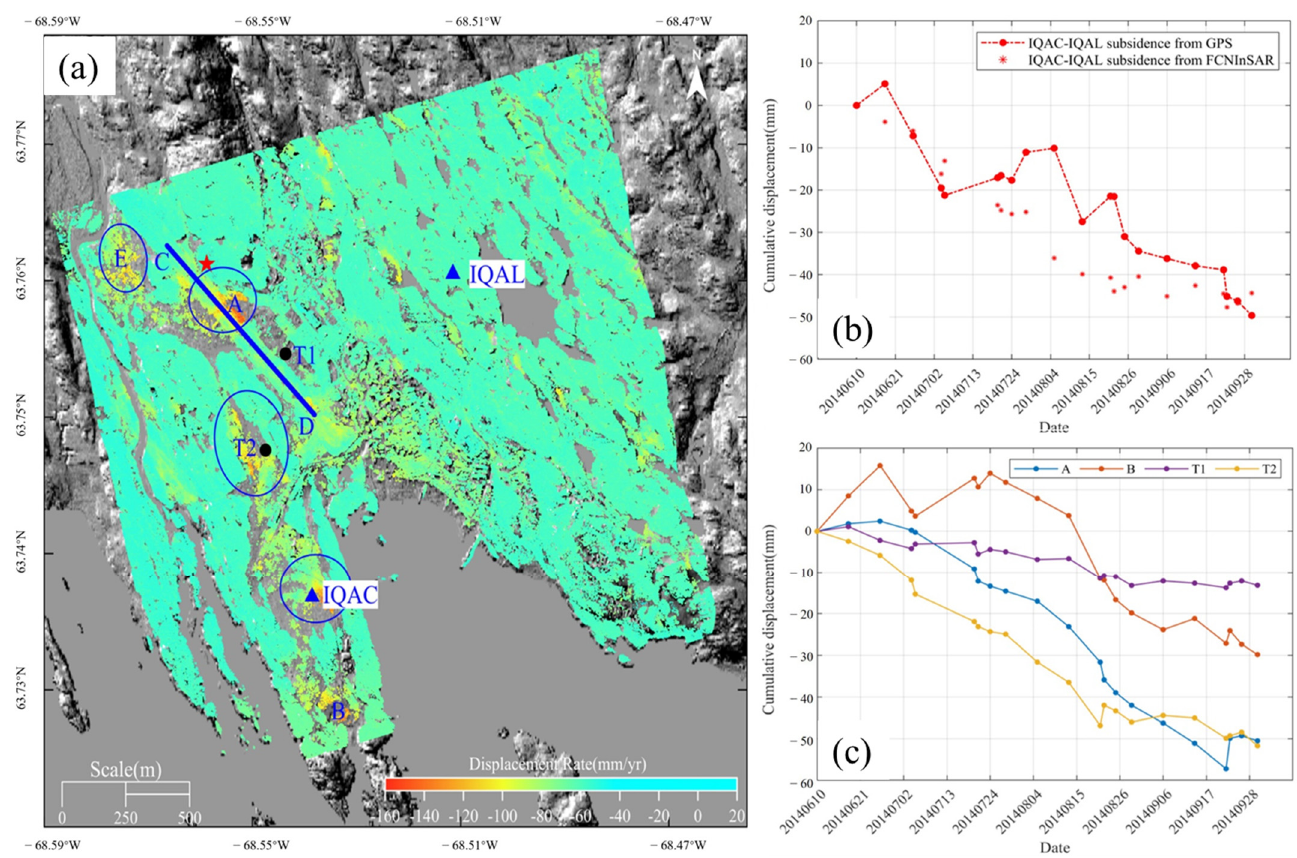
Figure 5. ( a ) Displacement velocities over the study area. The red star is the reference point for velocity calculation; blue triangles denote GPS stations; black dots denote two thaw tubes; black polygons represent infrastructure and facilities; the blue line labeled as CD is the profile site along runway 17/35 for further discussion; ( b ) cumulative subsidence between IQAL and IQAC from GPS measurement and FCNInSAR time series; ( c ) time series subsidence of four points labeled in ( a ).